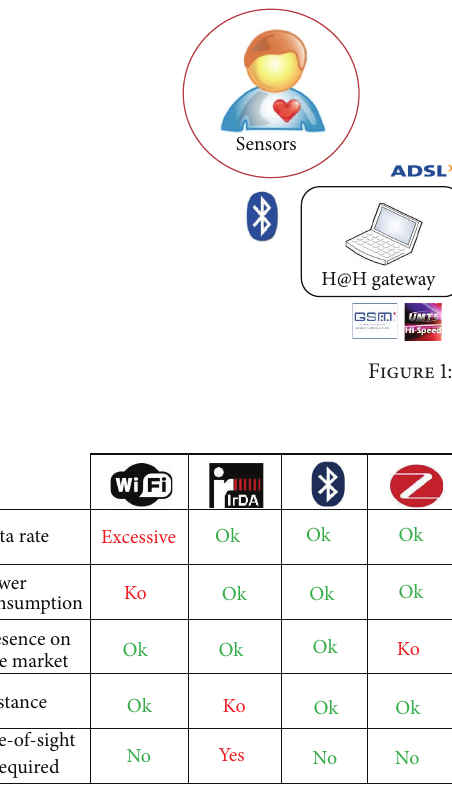
Figure 2: Comparison among wireless technologies for sensor network